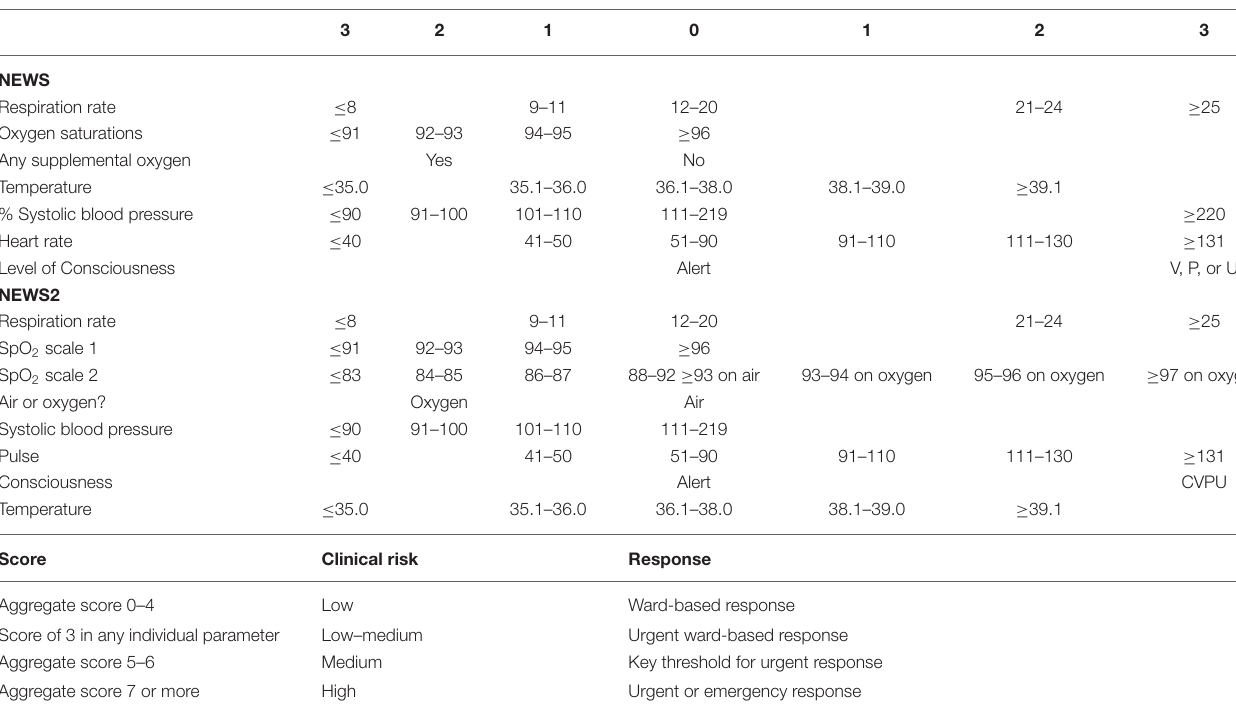
TABLE 1 | The NEWS scoring system, thresholds, and